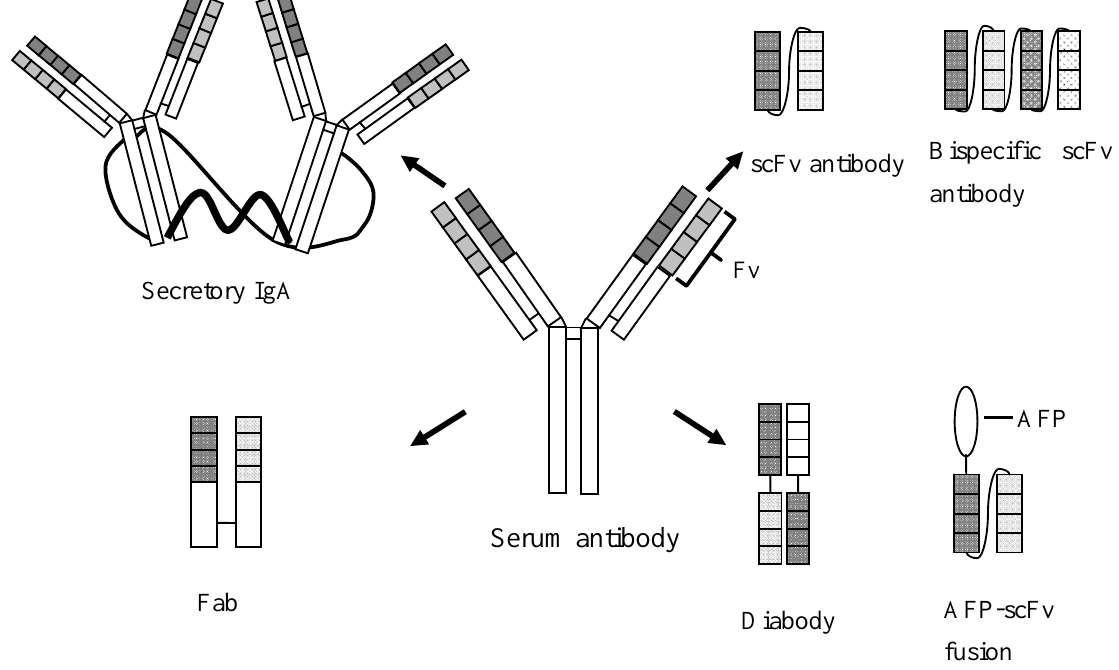
Figure 1. Different antibody forms expressed in transgenic